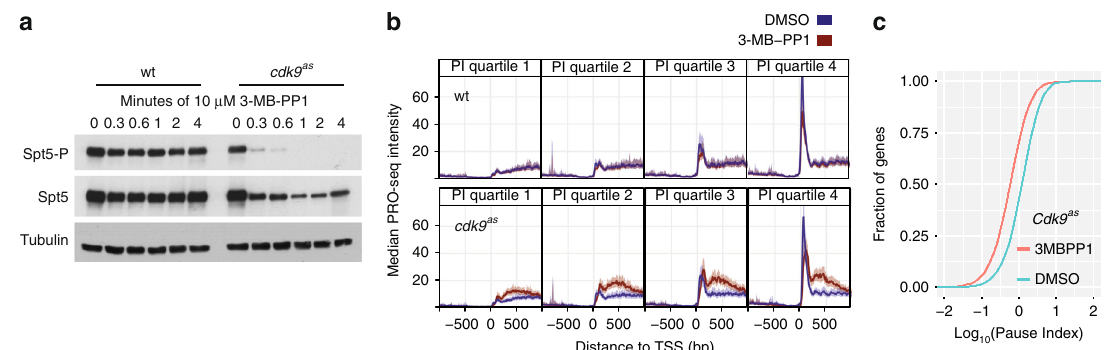
Fig. 1 Cdk9 is not required for promoter-proximal pause escape. a Western blot analysis using antibodies that speci fi cally recognize p Spt5 compared with total Spt5 in wt and cdk9 as over a time course of cultures treated with 10 μ M 3-MB-PP1. Total Spt5 represents both phosphorylated and unphosphorylated forms. Tubulin serves as a loading control. b TSS-centered composite pro fi les of PRO-seq data before (blue) and after (red) 5 min of treatment with 10 μ M 3-MB-PP1 for genes grouped by quartiles of increasing pausing index from left to right (calculated using untreated wild-type data from combined replicates). The top four panels represent wild-type data, while the bottom four panels represent cdk9 as data. Each quartile contains 841 fi ltered genes. c Cumulative density functions for pausing index (log 10 ) of all fi ltered genes in treated (red) and untreated (blue) samples for the cdk9 as strain. Data used in b and c re fl ect the results of combined data from two biological replicates for